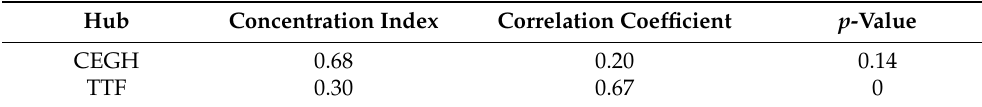
Table 4. Correlation coefficient and significance.